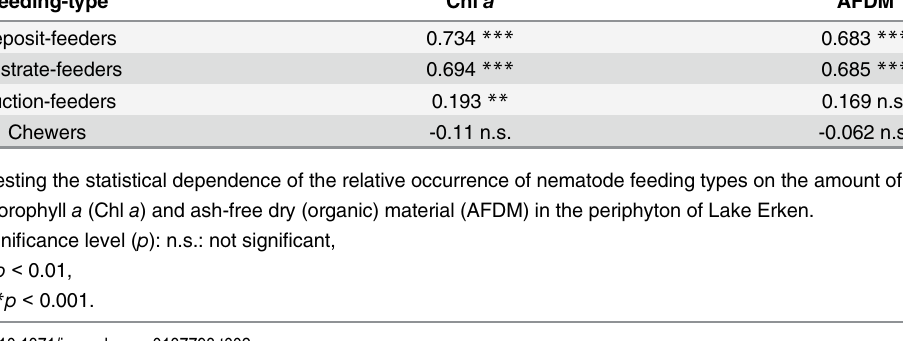
Table 2. Spearman correlation coefficient between feeding- type and Chl a and AFDM content. Feeding-type